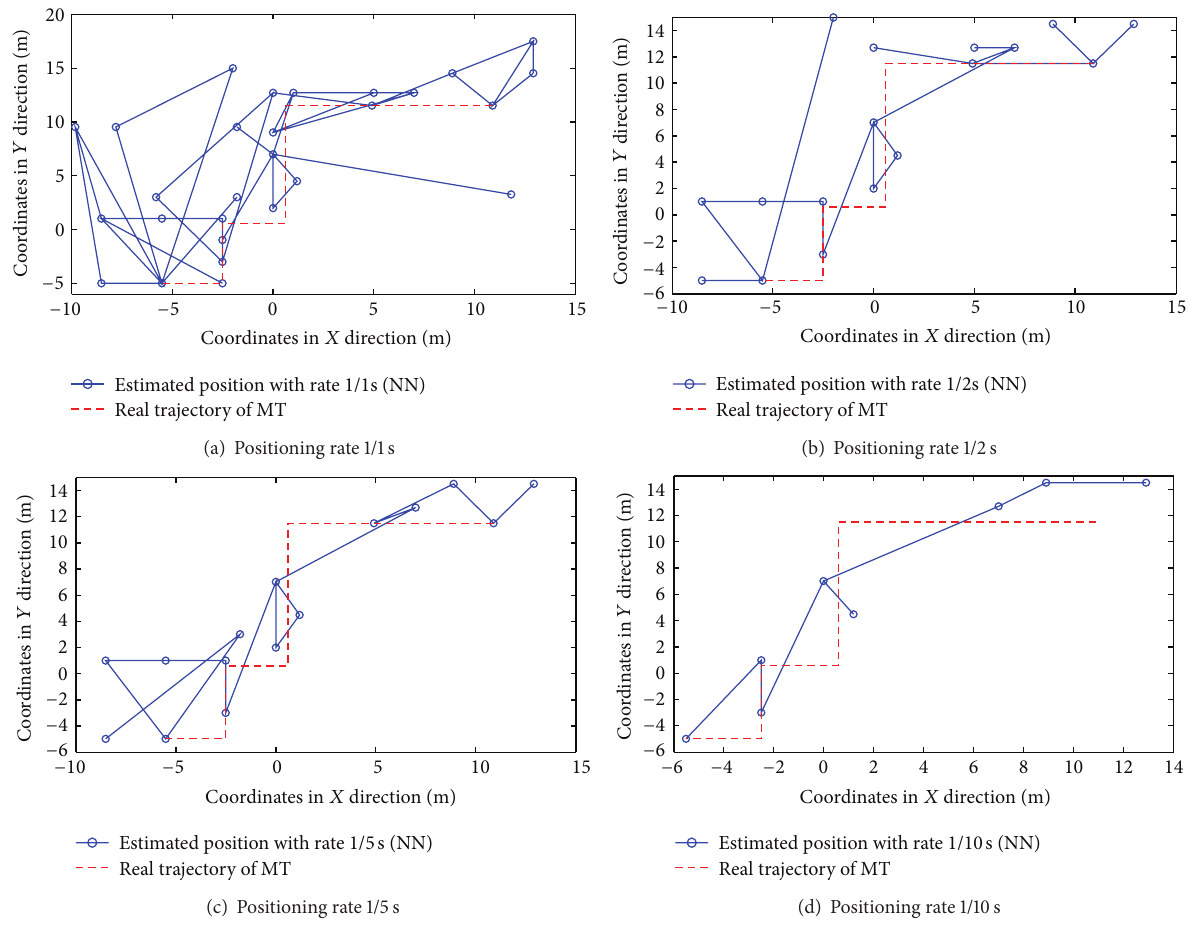
Figure 14: Results of dynamic positioning by NN